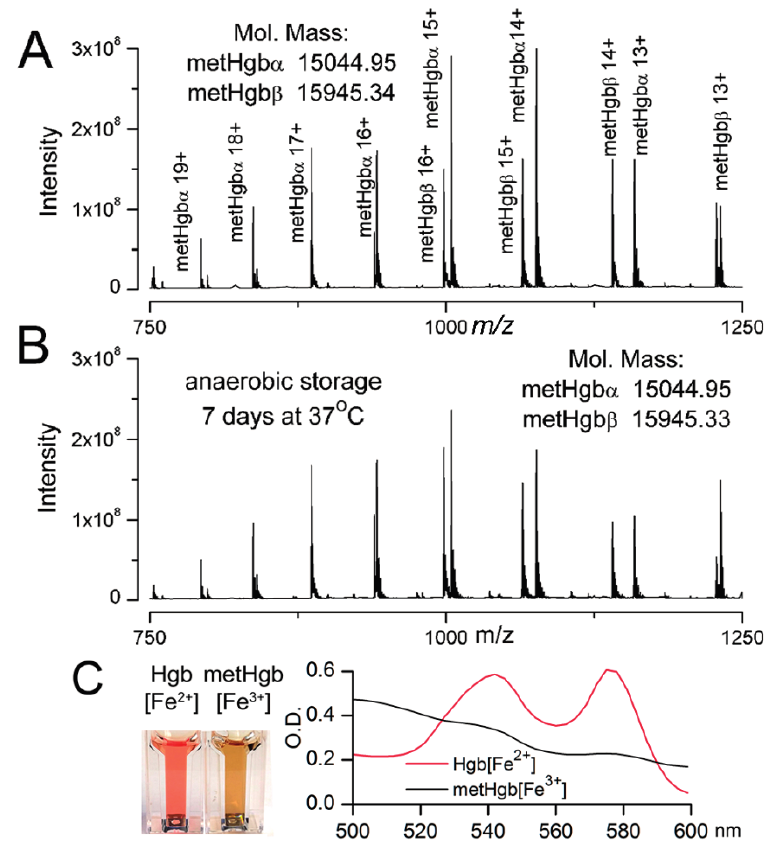
Figure 2. Characterization of metHgb after purification. ( A , B ) FT-ICR mass spectrometry of purified LPS-free metHgb that was freshly prepared ( A ); and of purified LPS-free metHgb maintained in solution under anaerobic conditions at 37 °C for 7 days ( B ), showing families of peaks for multiprotonated metHgb α or β and no contaminants; m / z , mass divided by charge; deconvoluted molecular masses for singly protonated hemoglobin α and β subunits, determined from the mass spectrum, also are shown; ( C ) Images ( left panel) and visible spectra ( right panel) of Hgb[Fe 2+ ] and metHgb[Fe 3+ ]